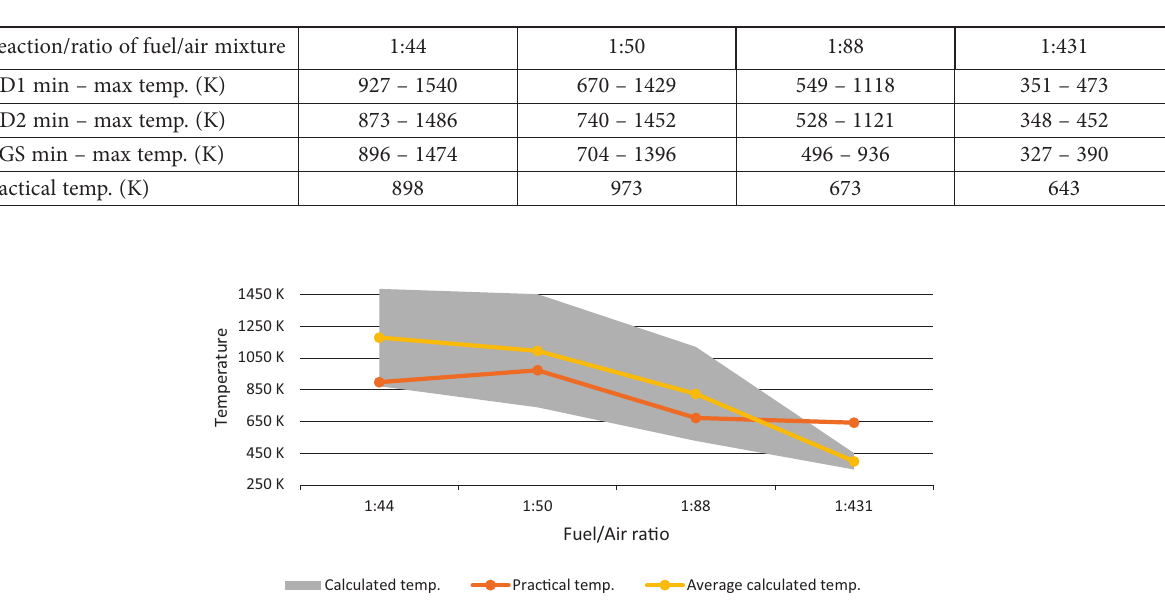
Figure 4. Comparison of theoretical and practical temperature using WGS